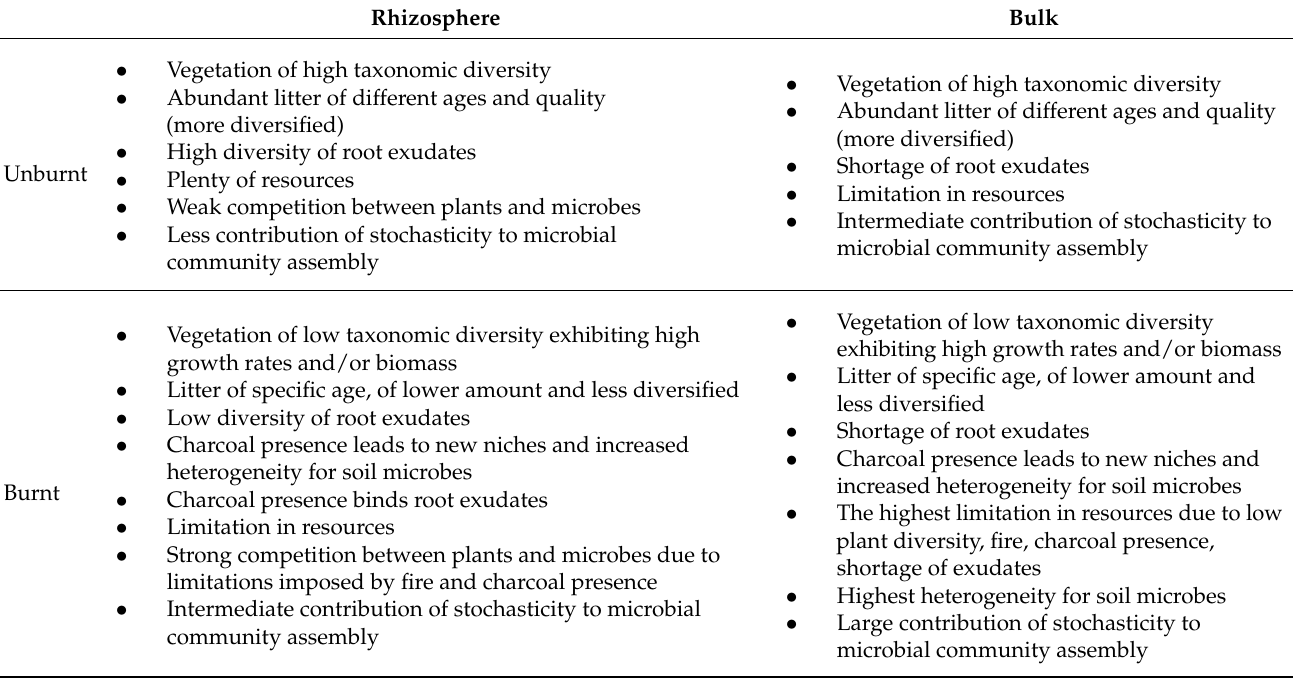
Table 4. Processes and agents affecting bacterial co-occurrence patterns in the burnt and unburnt rhizosphere and bulk